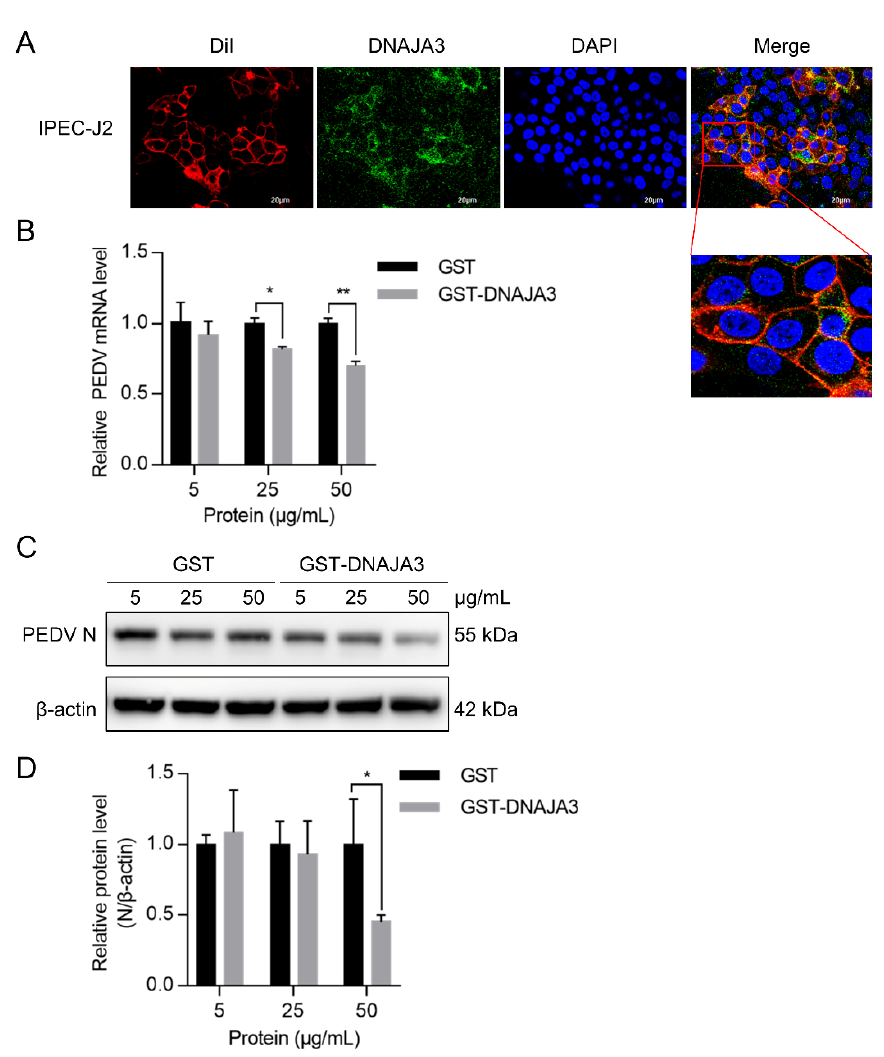
Figure 7. Pretreatment of PEDV with DNAJA3 protein inhibited its infection. ( A ): IPEC-J2 cells were analyzed to determine colocalization of fluorescent dye DiI that stains cell membranes (red) with DNAJA3 (green) with DAPI-nuclear staining (blue). ( B , C ): Different levels of GST or DNAJA3-GST protein (5, 25 and 50 µg) were mixed with PEDV (MOI = 1) and pre-incubated at 4 °C for 2 h. The IPEC-J2 cells were inoculated with the mixtures and incubated at 37 °C for additional 2 h to allow virus attachment. The culture supernatants were then replaced with DMEM containing 4 µg/mL trypsin and the plates continued to culture for 22 h. PEDV replication was shown as mRNA ( B ) and N protein ( C ) levels. ( D ) : Ratios of N protein to β -actin of panel C. The results are presented as the mean ± SD from three independent experiments. *, p < 0.05; **, p < 0.01.